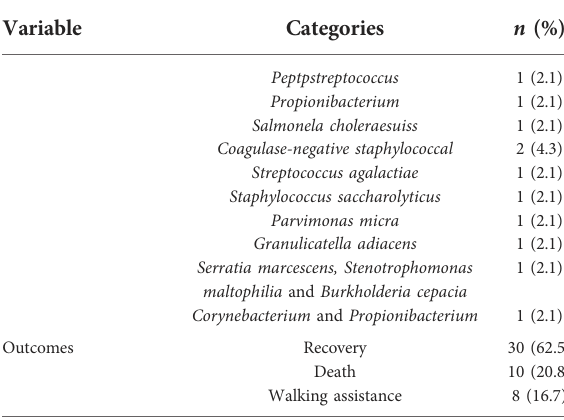
in 2 patients, while TS was con fi rmed by fi ndings from both